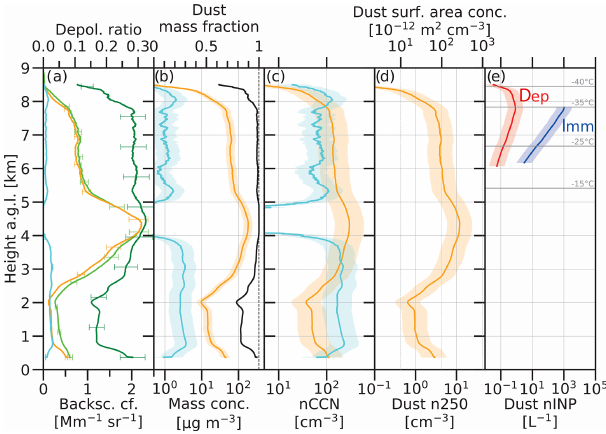
Figure 11. Overview of microphysical and cloud-relevant parti- cle properties obtained by applying the POLIPHON method to the polarization lidar measurements. The lidar measurement was per- formed on 23 April 2015, 21:00–21:34UTC. (a) The 532nm parti- cle backscatter coefficient (in green) and the particle linear depolar- ization ratio (in dark green) are used as input to obtain the results in (a) – (e) . The POLIPHON products are (a) the derived 532nm dust backscatter coefficient (yellow) and the non-dust backscatter coef- ficient (light blue), (b) dust mass concentration (yellow) and the non-dust mass concentration (light blue), and the dust mass frac- tion (black, ratio of the dust to total particle mass concentration, dashed black vertical line shows a dust mass fraction of 1), (c) dust and non-dust CCN concentrations (nCCN), (d) dust particle num- ber concentration n 250 and surface area concentration, and (e) dust- related INP concentration profiles when applying the INP param- eterizations for deposition nucleation (dep, in red, use of the dust surface area concentration as input) and immersion freezing (imm, in blue, with n 250 as input). Horizontal lines in (e) show the tem- perature levels on 23 April 2015. Error bars and ranges (shadows) indicate the uncertainty in the retrieved values.